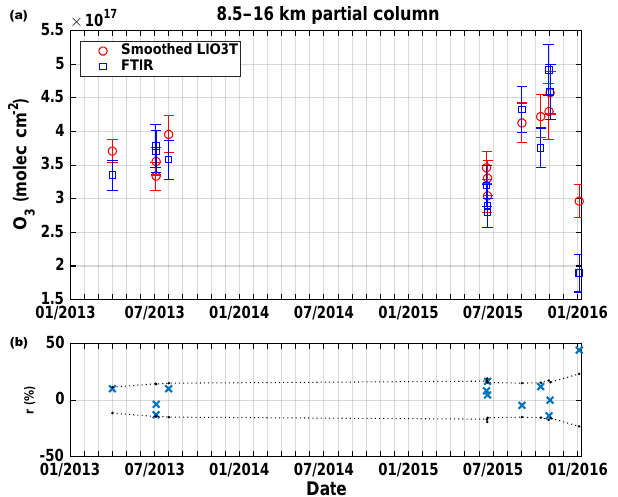
Figure 9. (a) Smoothed LIO3T (red circles) and IASI (blue squares) 6–16km O 3 partial columns. Vertical bars give uncertainties for each measurement. (b) r (%) between LIO3T and IASI measure- ments (blue crosses) superimposed on LIO3T + IASI uncertainties around zero (black dotted lines and